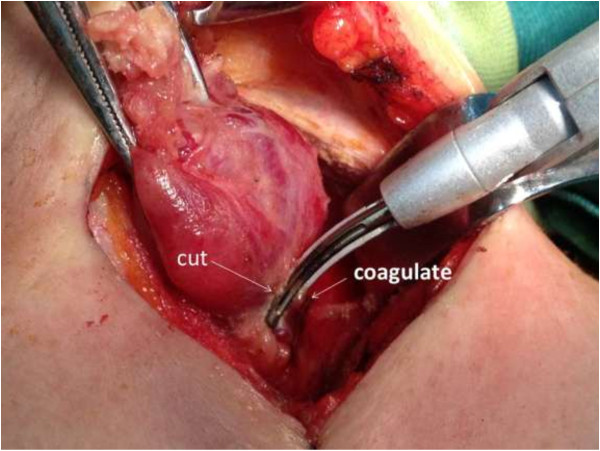
Ligation of the inferior thyroid vessels with a double-ligation technique. In the distal part of the artery we used the device just to coagulate the vessel. In the proximal part, after coagulation, we cut the tissue.